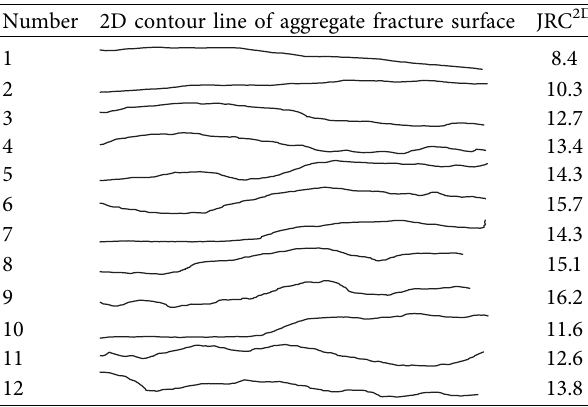
Table 5: 2D roughness of contour lines along the x -axis.